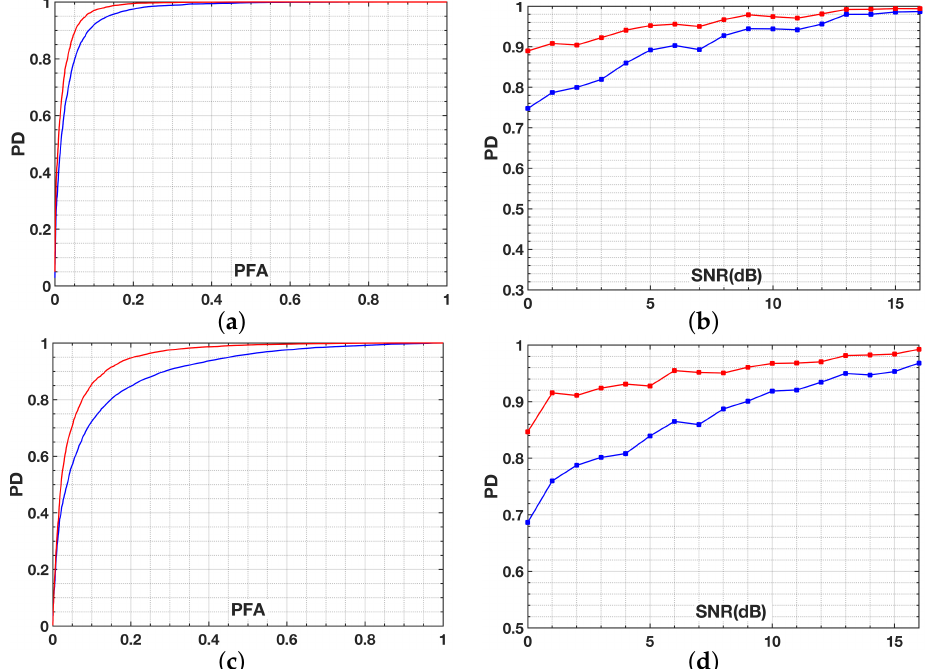
Figure 1. Performance assessment of the proposed method (red curves) and the existing scattering support GLRT [19] (blue curves). ( a , b ) are ROC and PD for the first stages of the tests in (16) and (10). ( c , d ) are ROC and PD for the second stages of the tests in (17) and